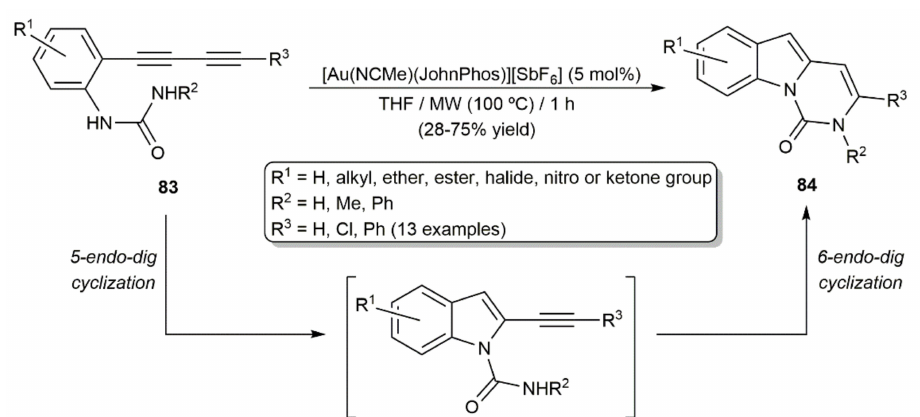
Scheme 46. Au-catalyzed conversion of diyne 75 into tetraindole 82